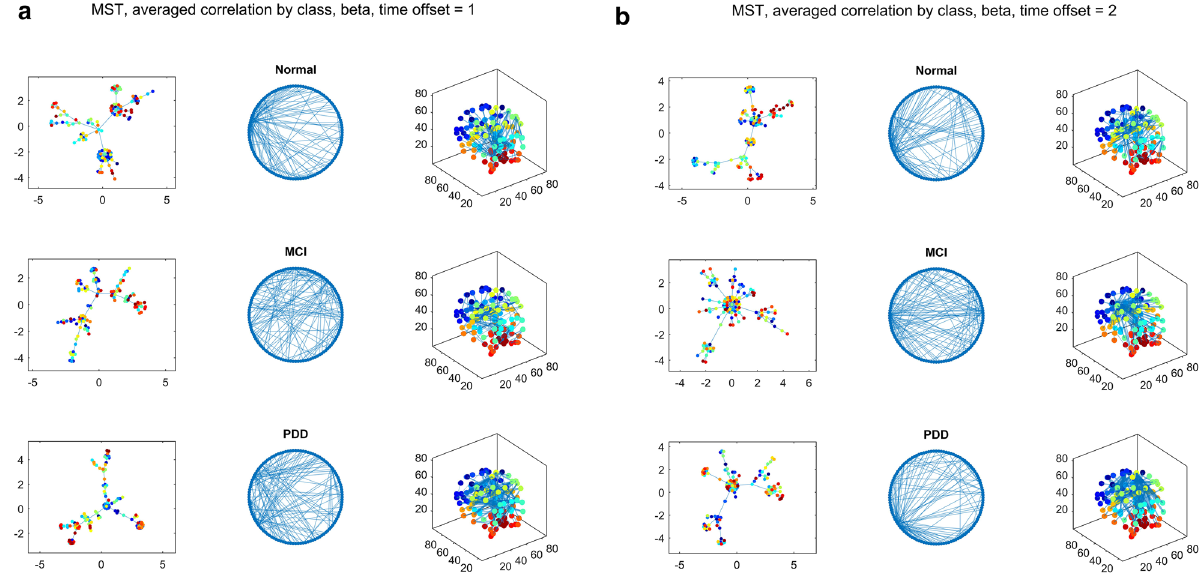
Figure 1. Examples of class-averaged parcel-correlation MSTs for beta-band frequencies and time offsets of dt = 1 ( a ) or dt = 2 trials ( b ). The left columns show the MSTs in a force-directed 2D layout, with nodes colored by parcel identity; middle columns show MSTs in a standard circular format which allows visual comparison; right columns show the locations of MST connectivity with respect to parcels’ positions in the brain. Substantial differences in overall connectivity are visible between the three disease classes, “normal cognition”, “MCI”, and “PDD”. PDD tends to show a more disorganized pattern in this band, with less prominent high-degree “hub”